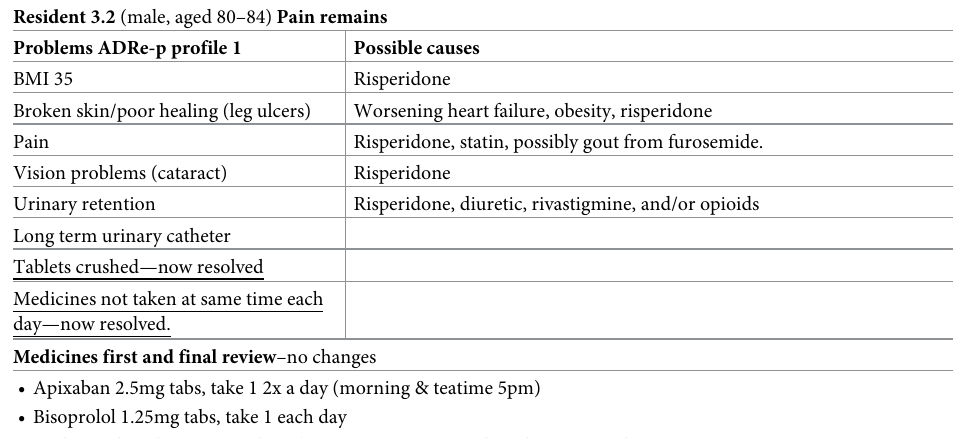
Table 4. Residents with no recorded clinical